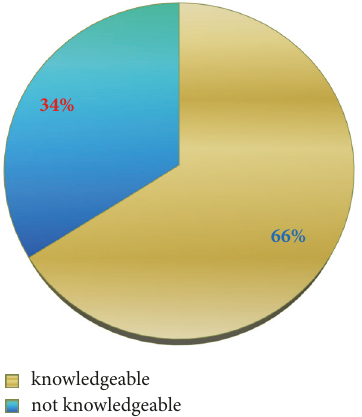
Figure 3: Distribution of the level of knowledge of hand washing, Dubti Referral Hospital, April 2016.